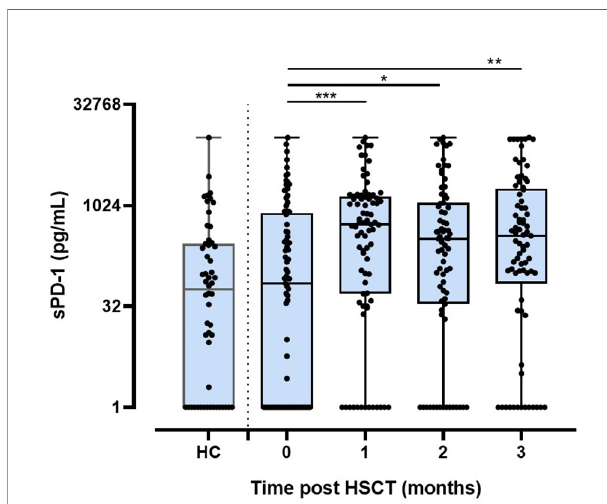
FIGURE 1 | Levels of sPD-1 in healthy controls and in patients before and post HSCT during the fi rst three months. HC, healthy controls (n=54); 0: before HSCT; 1, 2, 3: one, two, three month(s) post HSCT; *p < 0.05, **p < 0.01; ***p < 0.001.